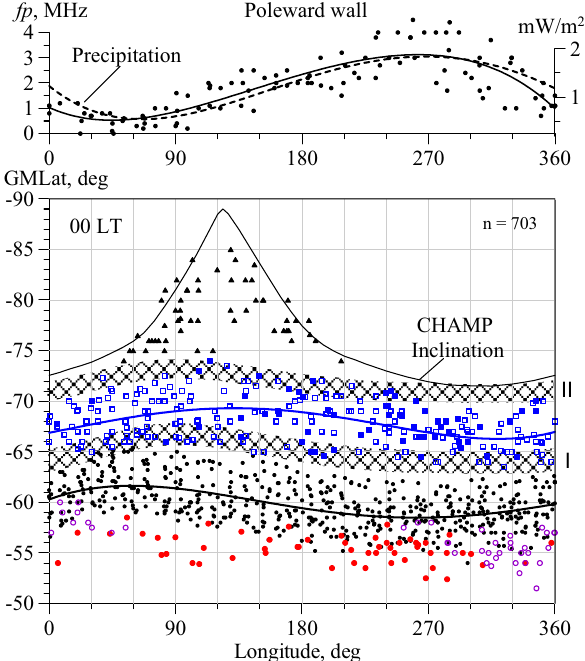
Figure 1. On the top: Longitudinal variations in the magnitude of MIT poleward wall (dots and approximation) and averaged auroral precipitation energy flux at 21-03 MLT under Kp = 2 (dashed line) 19 . On the bottom: Longitudinal variations in the positions of main structures in the near-midnight winter ionosphere of the southern hemisphere: polar hole (triangles), HLT1 (empty squares), HLT2 (filled squares), MIT (black dots), RIT (red dots), and specific electron density minima (purple empty circles). The shaded latitude belts show the diffuse auroral precipitation in zones I and II 19 . The upper curve represents the CHAMP inclination equal to